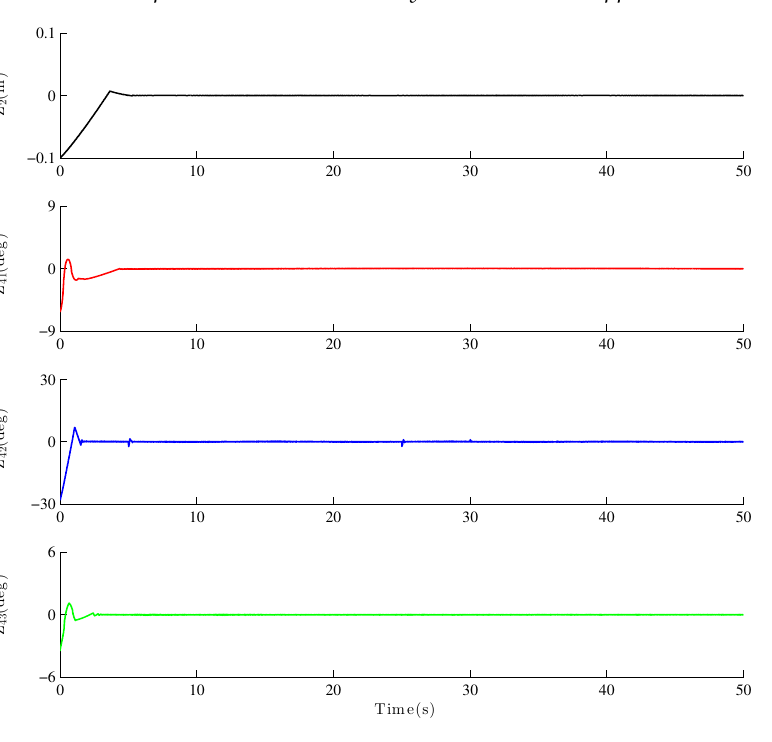
Figure 6. Time response of observation errors of